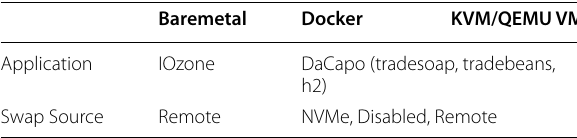
Table 3 Experimental setup for performance